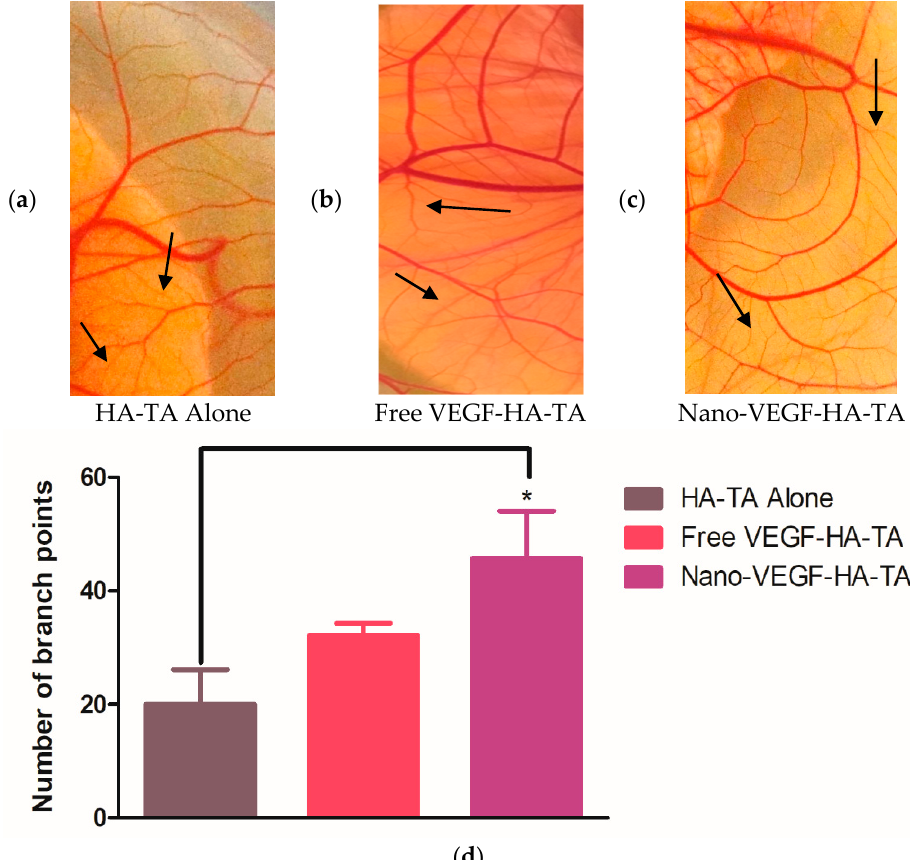
Figure 4. ( a ) A section of CAM from a membrane exposed to HA-TA alone. Some branch points are evident, but they are not as numerous as those observed in ( b ) a section of CAM from the free VEGF-HA-TA group or ( c ) a section of CAM from the nano-VEGF-HA-TA group. ( d ) Quantification of the number of branch points in a 16 mm region of interest surrounding the hydrogels. Free VEGF-HA-TA and nano-VEGF-HA-TA both contain 500 ng VEGF. * p < 0.05. ( n = 5).